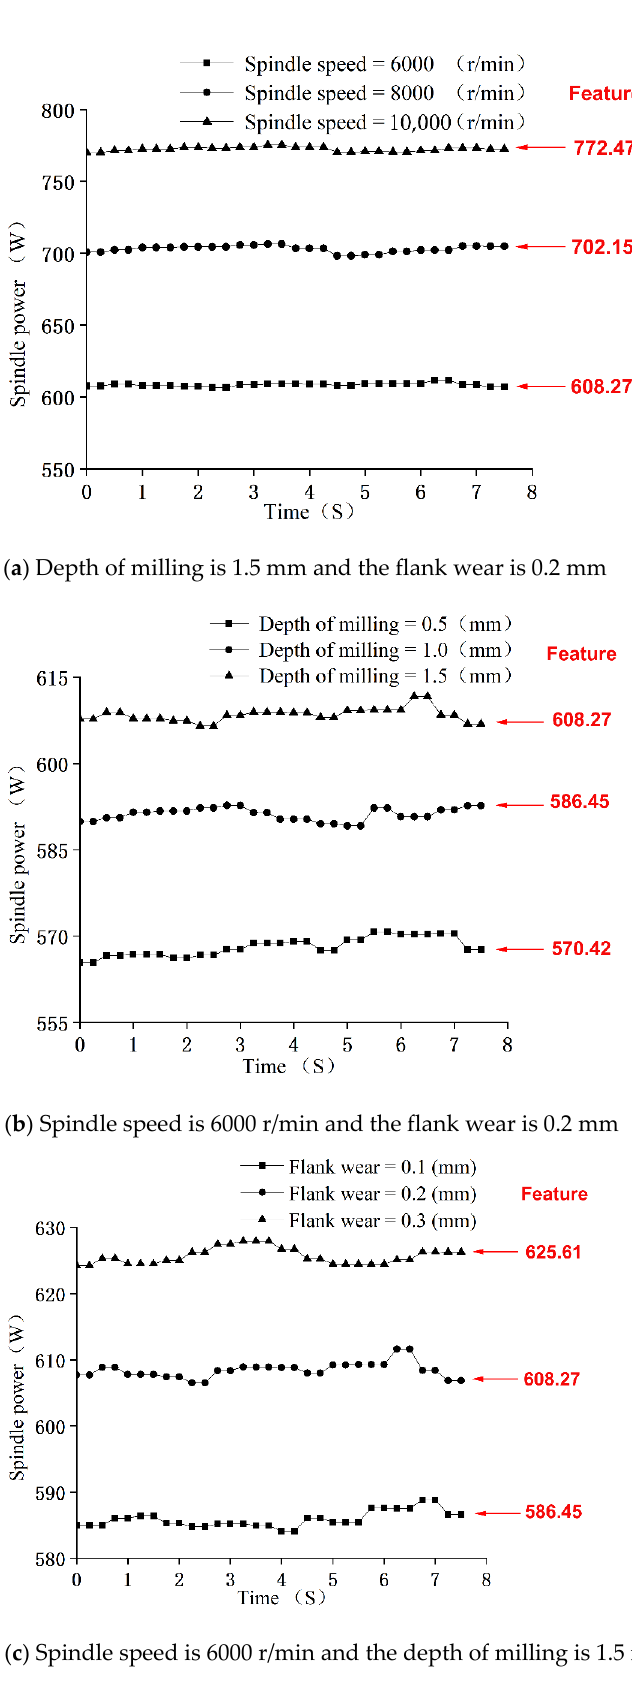
Figure 4. Comparison of the features and the average value of the spindle power signal under the spindle speed ( a ), the depth of milling ( b ), and the tool wear conditions ( c ). Table 4 shows a sample of woodworking tool wear conditions under different milling parameters. The spindle speed, depth of milling, and features of the spindle power signal were used as input vectors, and the tool wear conditions were used as the output vector. Table 4. Sample of woodworking tool wear conditions. Sample ID